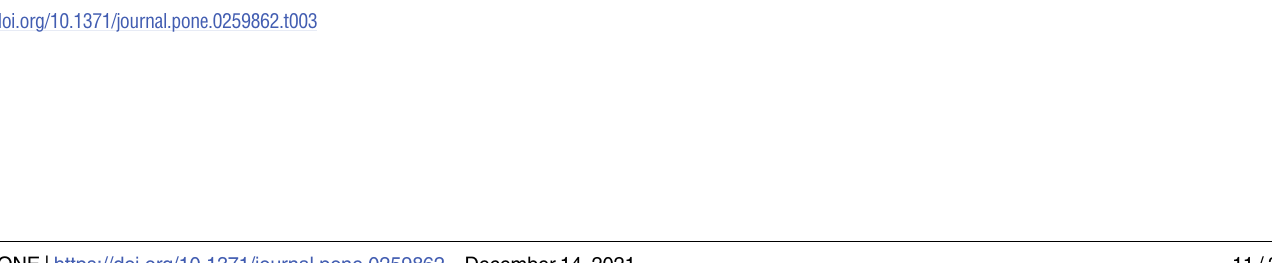
a Repeated measures GLM ANOVA of the body posture with main factors “Group”, “Vision” and “Adaptation” and their factor interactions. The F-values are presented within the parenthesis. The significant differences are marked in bold text and the trends in italic